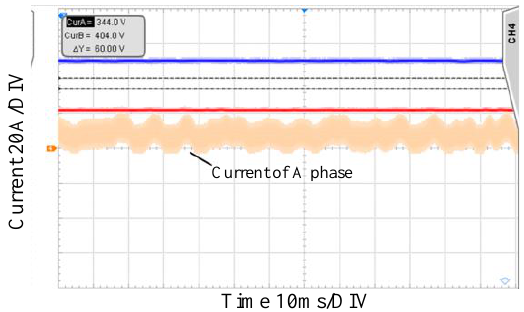
Figure 4. The three-branch fluctuating current caused by the large proportion parameter.